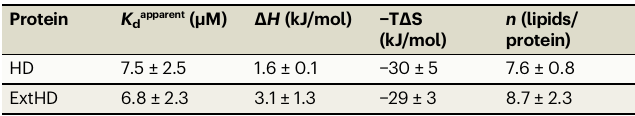
Table 2 | Thermodynamics of interaction of ExtHD and HD with POPG LUVs (100 nm), determined by ITC Protein K d apparent ( μ M)